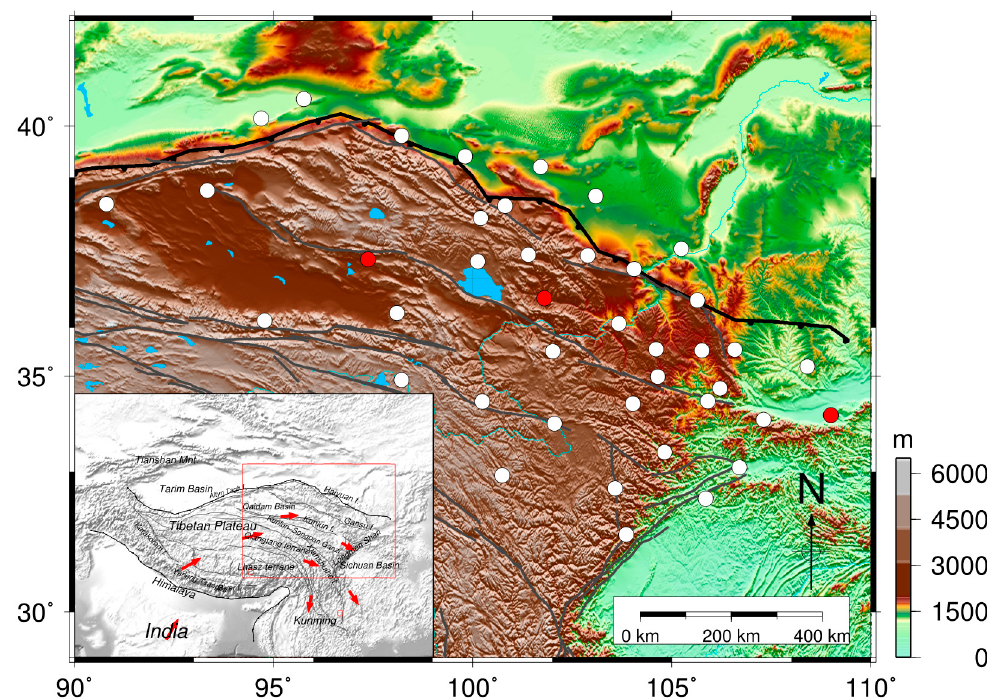
Figure 2. Locations of the CGPS stations in northeastern Tibet. The white circles are the CGPS stations with records spanning from March 2010 to July 2015, and the red circles denote the three stations with records spanning from January 1999 to July 2015. The map in the inset shows the geological tectonic background and crustal motions with the collision and post-collisional intra-continental deformation of the Indian and Eurasian plates. The red arrows indicate direction of large-scale block motions, and faults and subduction belts are indicated by the gray and black lines, respectively. Table 1. GPS stations with their vertical velocities, and GRACE-derived uplift rates.